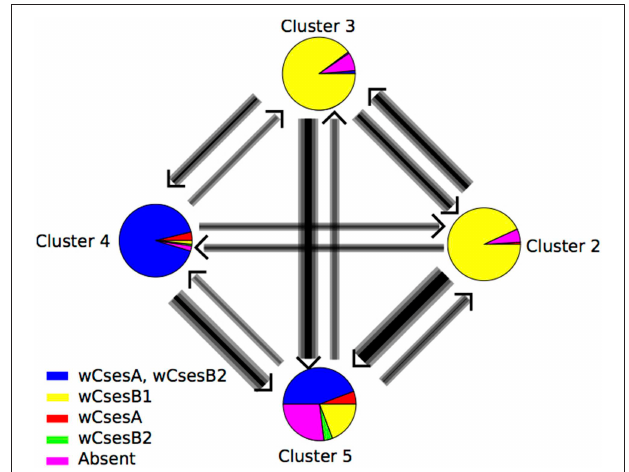
FIGURE 4 | Estimates of gene flow between four geographic genetic clusters of Cotesia sesamiae wasps identified by Instruct. Each circle represents the infection status of individuals found assigned to each cluster and the colors correspond to the ones in Figure 3 . The fifth genetic cluster, found only infecting Sesamia nonagrioides, was excluded from the analysis.